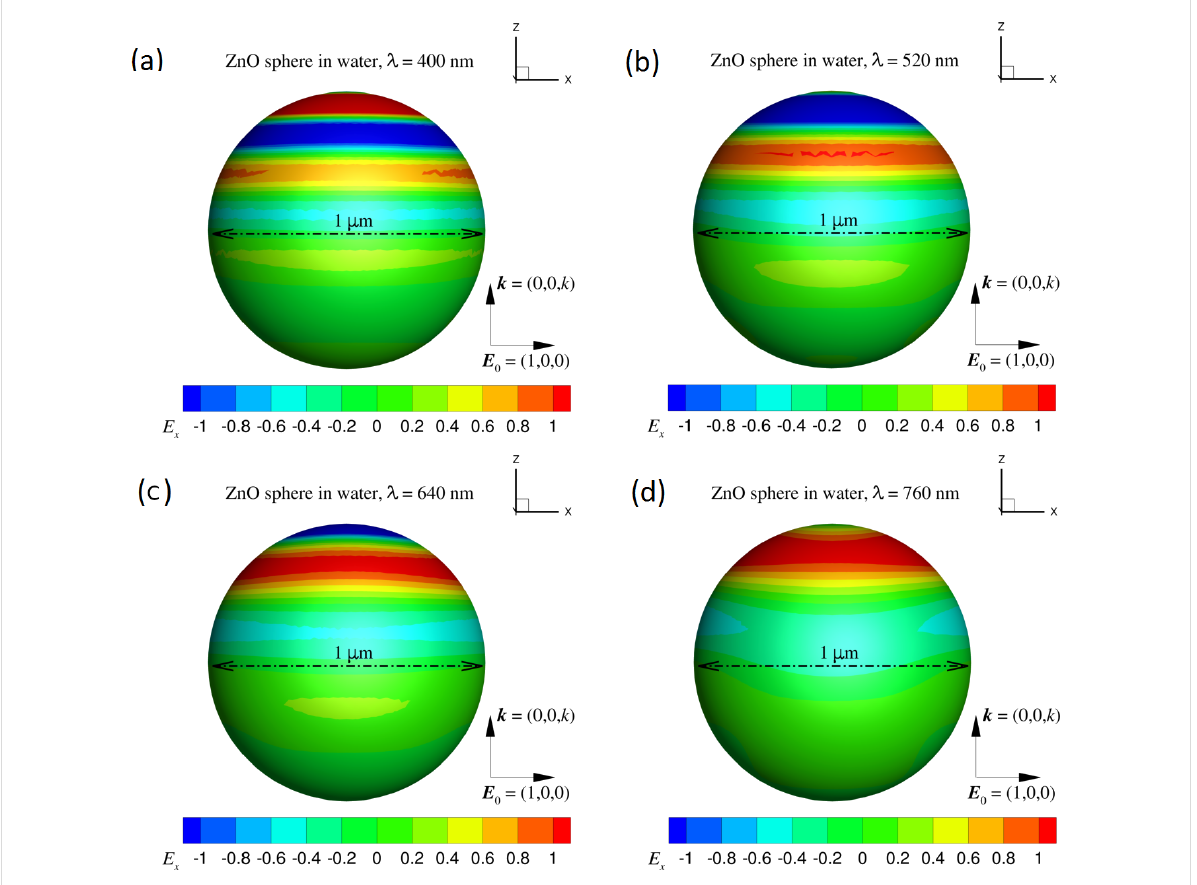
Figure 6: The total electric field on the surface of a ZnO sphere with diameter of 1 µm due to an incident electric field E inc = (1,0,0) exp( ikz ) where λ = 400 to 760 nm. The magnitude of the field, E x , is given by the color scale.